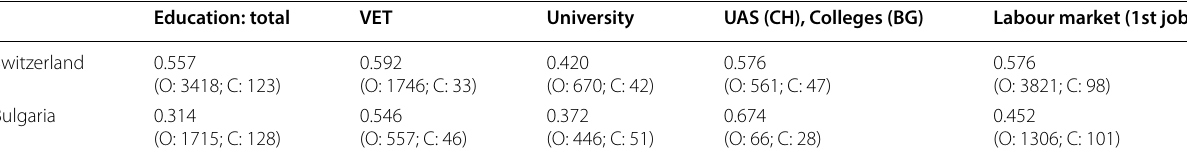
Education: ISCED97 3-digit; Labour market: ISCO88 3-digit. O: Number of observations; C: Number of categories